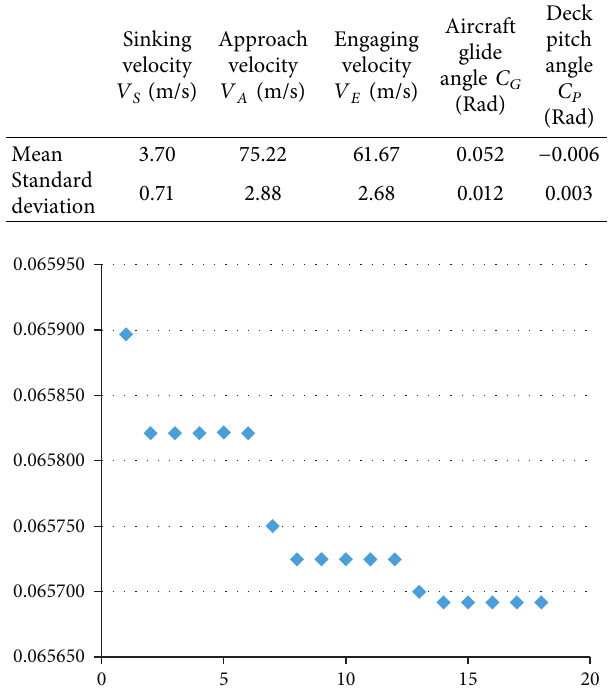
Figure 2: The convergence process of objective function by using Lagrange multiplier